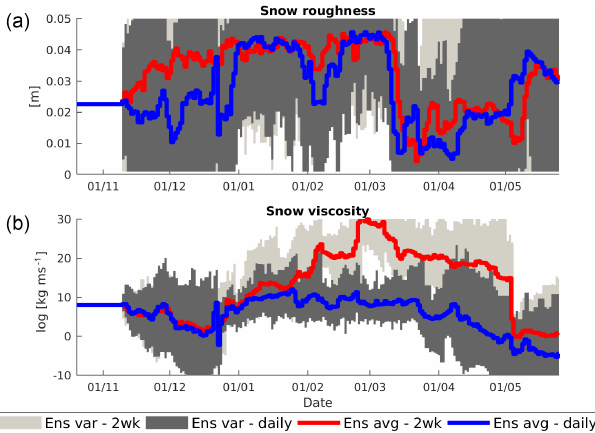
Figure 9. Sensitivity analysis of the multivariate DA scheme to SWE measurement frequency at CDP site, winter 2001/2002. Pa- rameter ensembles: snow roughness (a) and snow viscosity (b) , re- sulting from the assimilation of daily (average trend in blue) and biweekly (red) SWE